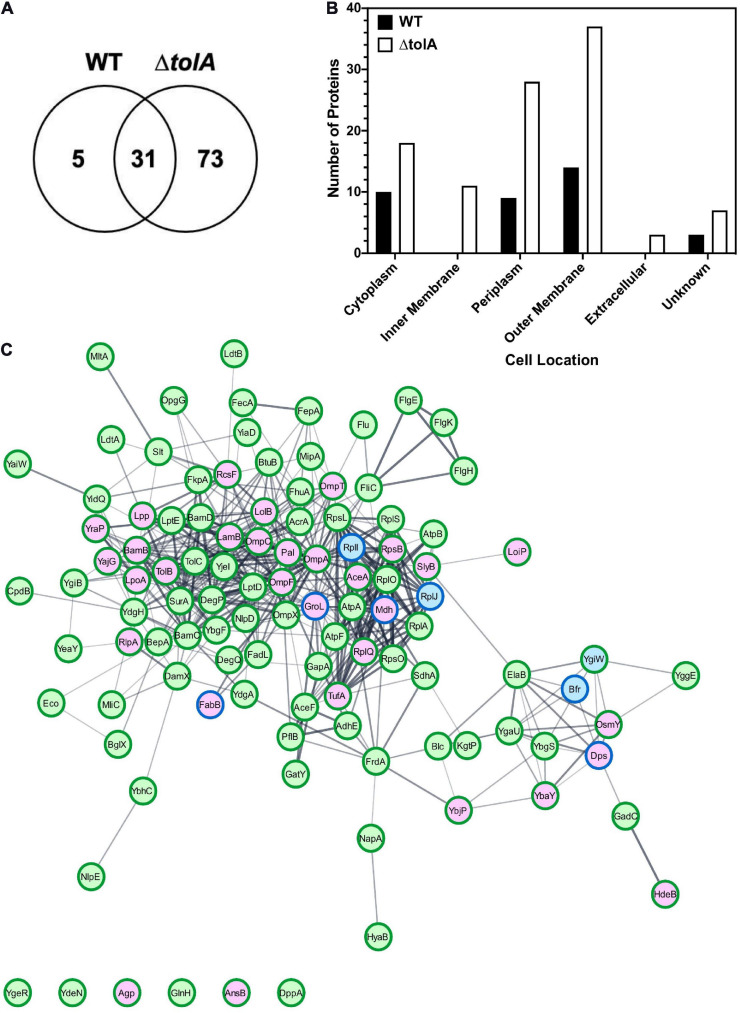
Proteomic characterization of WT and ΔtolA vesicles isolated by UF. (A) Venn-diagram of identified proteins showing overlap between WT and ΔtolA vesicle samples. (B) Cellular localization of identified proteins from WT (black) and ΔtolA (white) vesicle samples. (C) String network of interacting proteins from WT (blue), ΔtolA (green), or both (purple) vesicle samples. Border colors represent protein abundance, with dark green borders denoting upregulation of the protein in the ΔtolA sample, and dark blue borders denoting upregulation of the protein in the WT sample. The network diagram was generated using the StringApp v1.5.0 in Cytoscape v.3.8.0 (Doncheva et al., 2019). All data used in this analysis are summarized in Table 1.